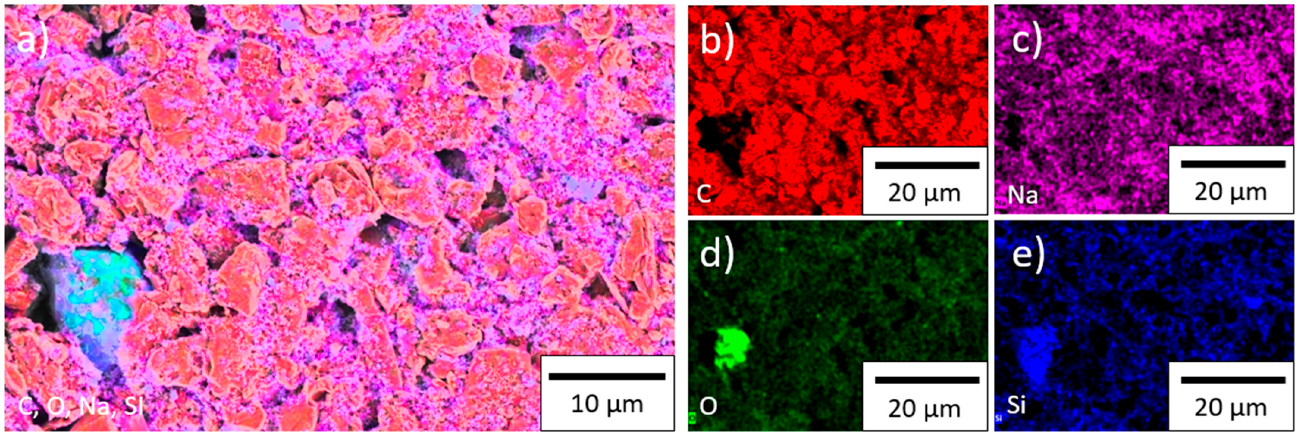
Figure A6. EDX measurements of the SSN electrode: ( a ) all detected elements, ( b ) carbon, ( c ) sodium, ( d ) oxygen, and ( e ) silicon. Table A1. Measurements of the structures that were generated by a laser beam.